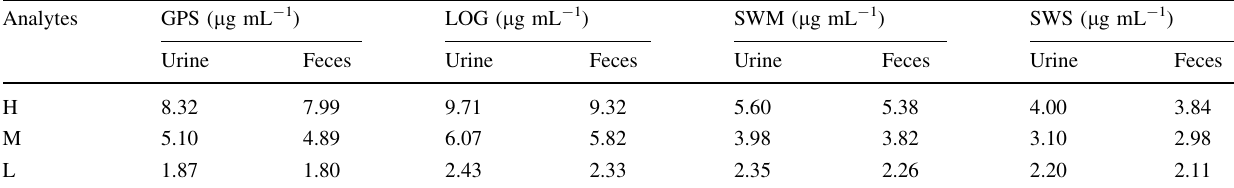
Table 2 Concentrations of four analytes in urine and feces QC samples